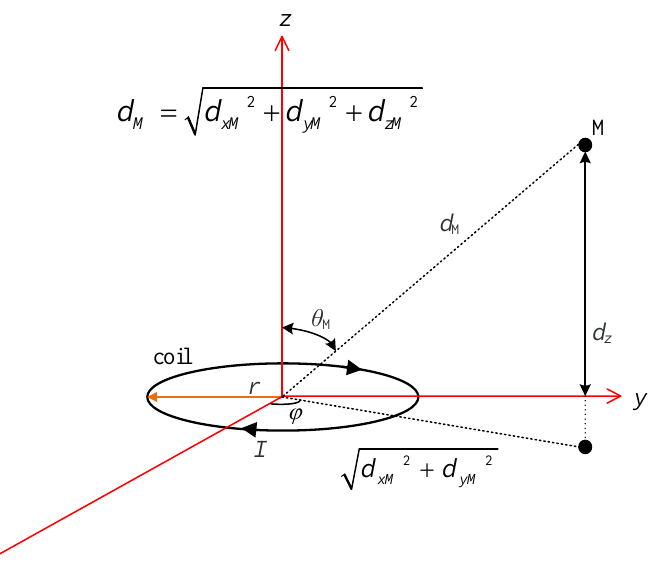
Figure 2. Geometric model of the distance from the center of the coil to point M. Note that µ 0 is the vacuum permeability, k is the wave number (2 π / λ ), λ is the wavelength ( c / f ), c is the speed of light (3 × 10 8 m/s), f is the frequency, r N ( N = 1, 2, . . . , n ) is the coil radius, and N is the coil